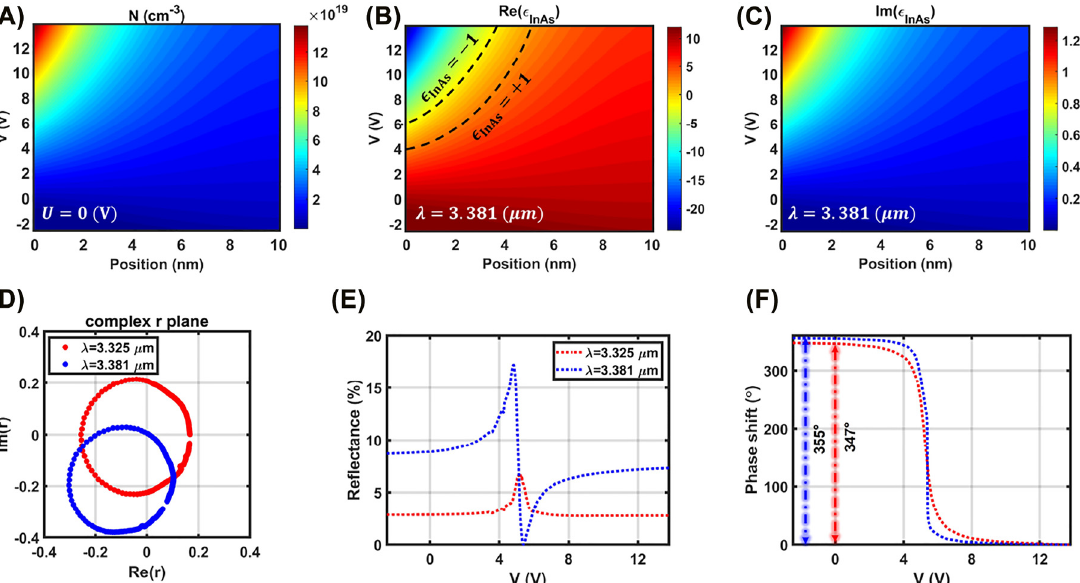
Figure 2: Electro-static and dynamic response of the metasurface to the external bias voltage. (A) Spatial distribution of the carrier density within the InAs active layer as a function of applied bias voltage of V , when U is set to 0 V. (B) Real and (C) imaginary parts of the InAs permittivity as functions of the bias voltage and position at the operating wavelength of 3.381 μ m. The dashed contours in (B) specify the boundaries of the ENZ region. (D) The complex reflection coefficient of the plasmonic metasurface by varying the bias voltage V calculated at two operating wavelengths of 𝜆 = 3.325 μ m (red curve) and 𝜆 = 3.381 μ m (blue curve). The corresponding (E) reflectance and (F) phase response of the metasurface under the application of bias voltage of V when U is adjusted to 0 V. The large phase span of 355 ◦ can be